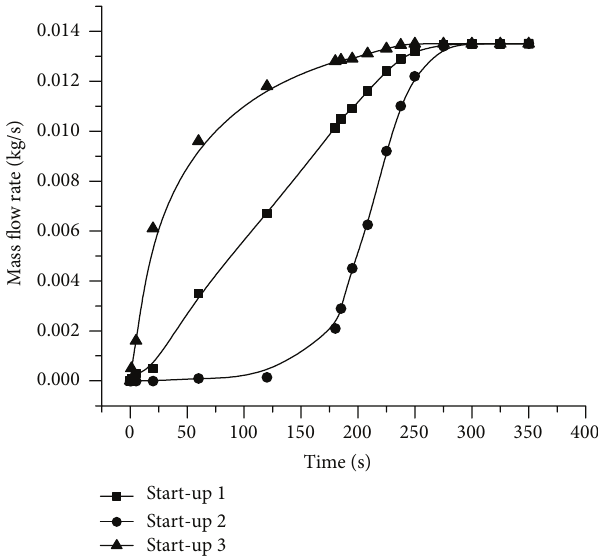
Figure 2: Turbine start-up curves